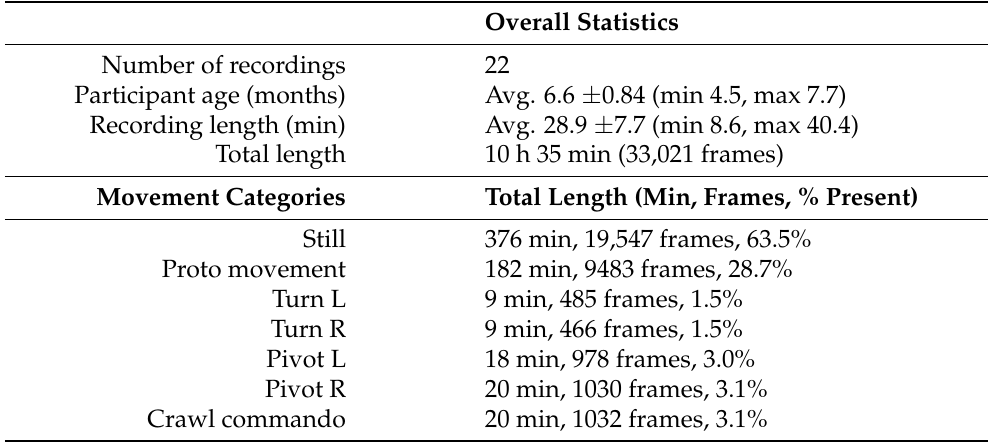
Table 1. Details of the utilized infant motility